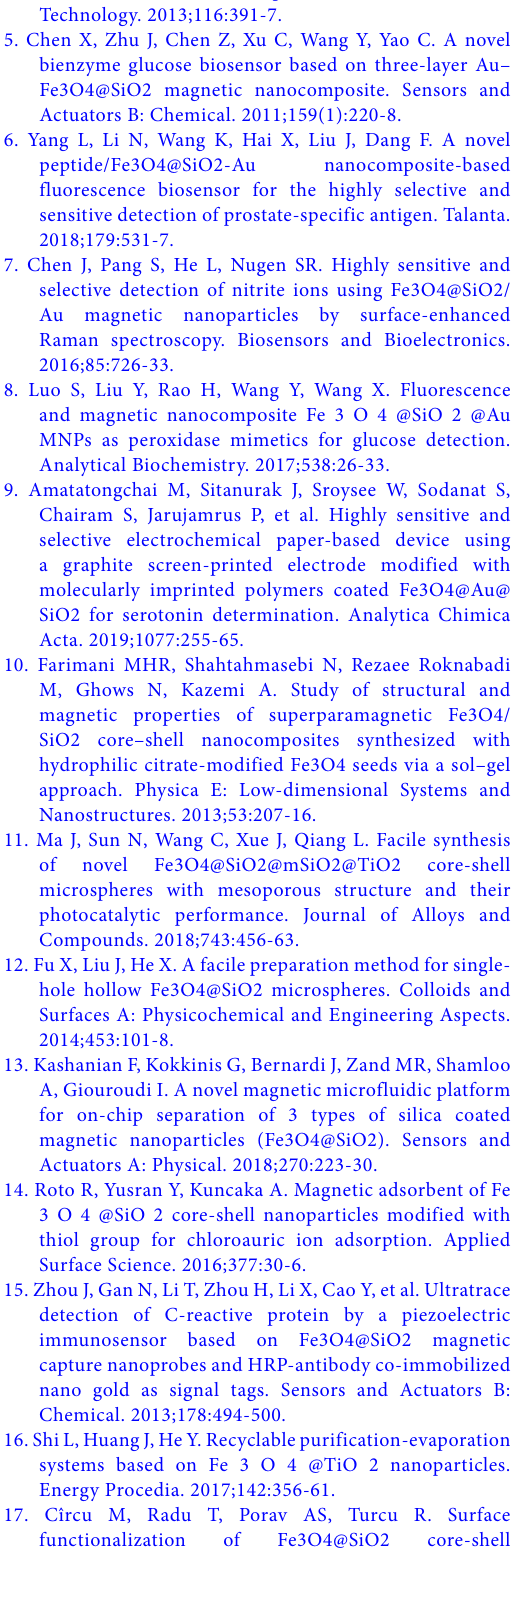
201 Nanomed Res J 4(3): 193-203,